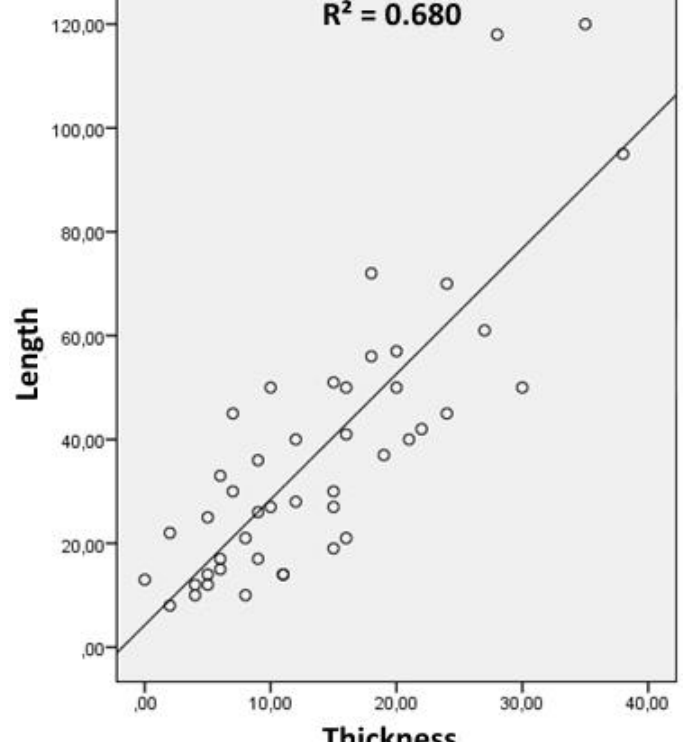
Figure 5. Coefficient of determination: R² Correlation of debitage/core-flakes platforms length and